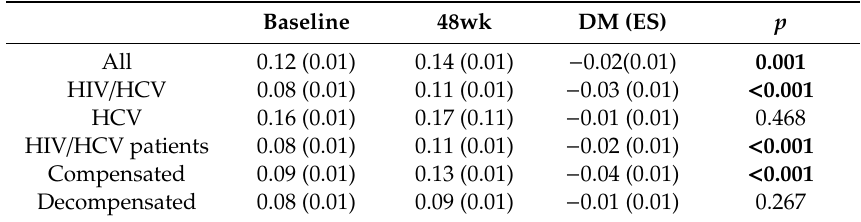
Table 3. Mean differences in RTL at baseline and 48 weeks after completing HCV treatment. Patients were stratified based on HIV coinfection and decompensation (mixed GLMs).